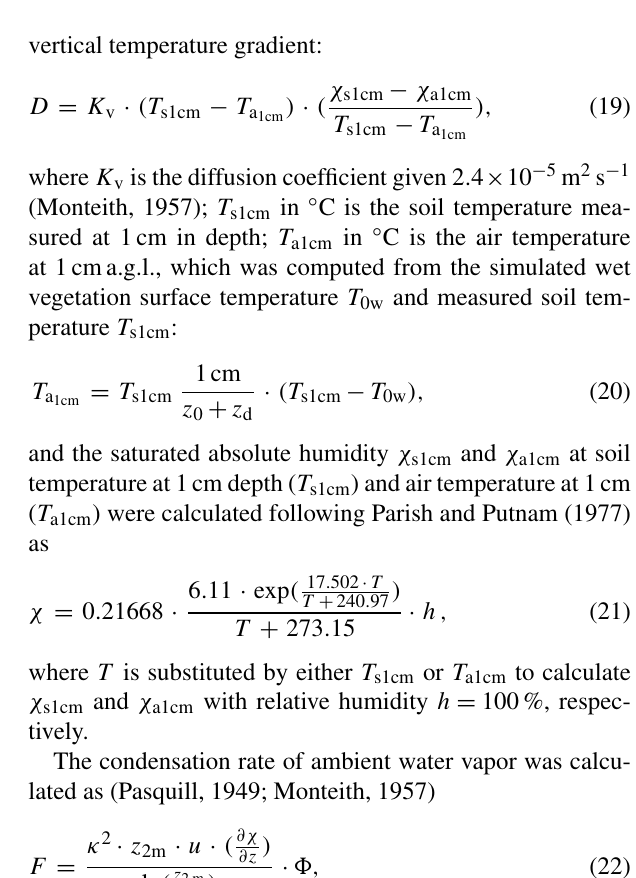
Figure 2. Simplified schematics of non-rainfall water (NRW) inputs adapted from Monteith and Unsworth (2013) and Oke (2002): at z 0 + z d = 0 . 16–0.23ma.g.l., NRW on foliage (i.e., fNRW) is a mixture of condensate from ambient water vapor (downward) and distillation (i.e., condensate from soil-diffusing vapor, upward). Mean vegetation height was 0.2–0.3m during the three events; eddy covariance and meteorological measurements were at 2.0–2.4ma.g.l.; L2130-i measurement was at about 6ma.g.l. Horizontal mean wind speed ( u ) was zero at height = 0.16–0.23ma.g.l. Temperature ( T ) was measured at 1cm in soil ( T s1cm ) and 2ma.g.l. in the atmosphere ( T a2m ); surface temperature ( T 0 = T 0w ) was derived from radiation measurement as shown in Eq. (1); air temperature at 1cma.g.l. was derived from soil temperature ( T s1cm ) and surface temperature ( T 0 = T 0w ) as shown in Eq.